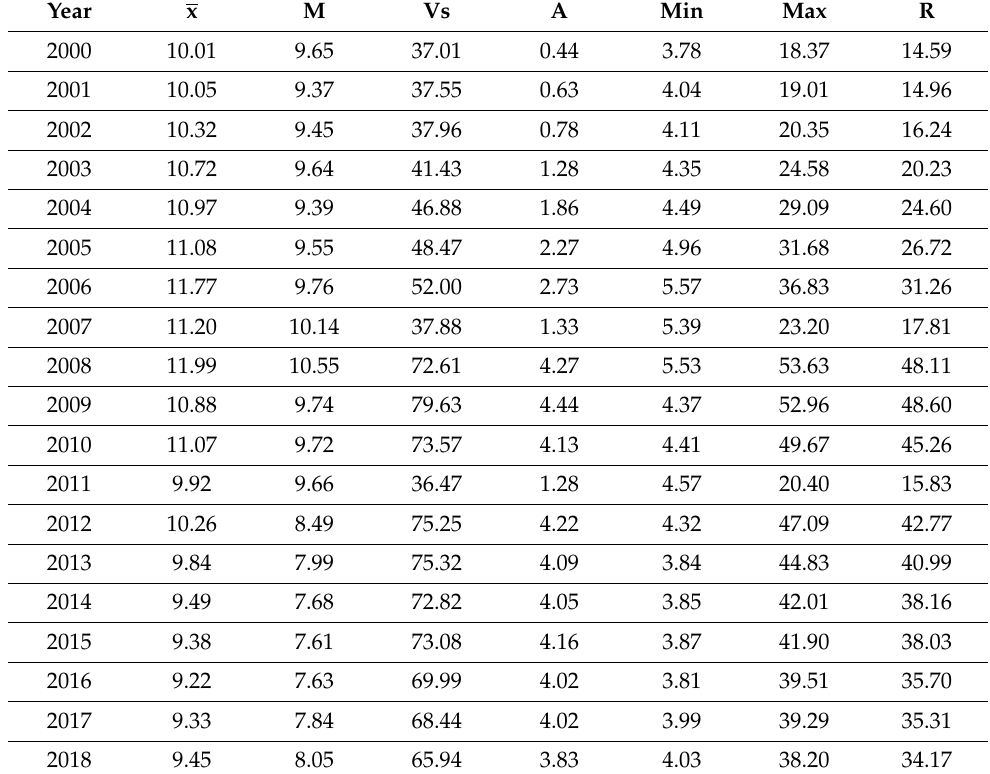
Table 1. Selected descriptive parameters for the indicator: CO 2 emissions per capita in the years